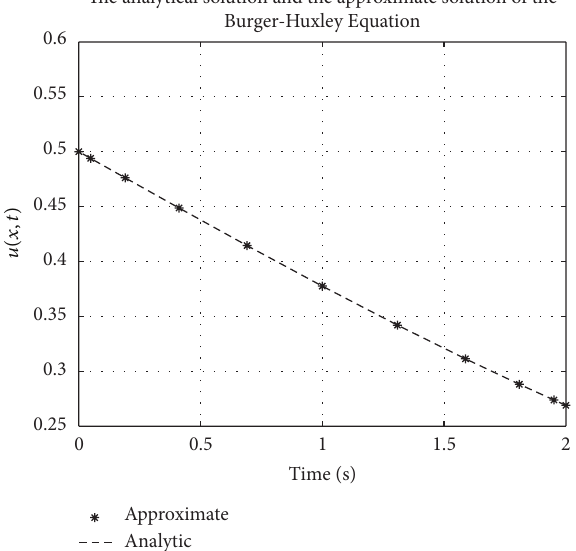
Figure 6: Modified KdV equation analytical solution